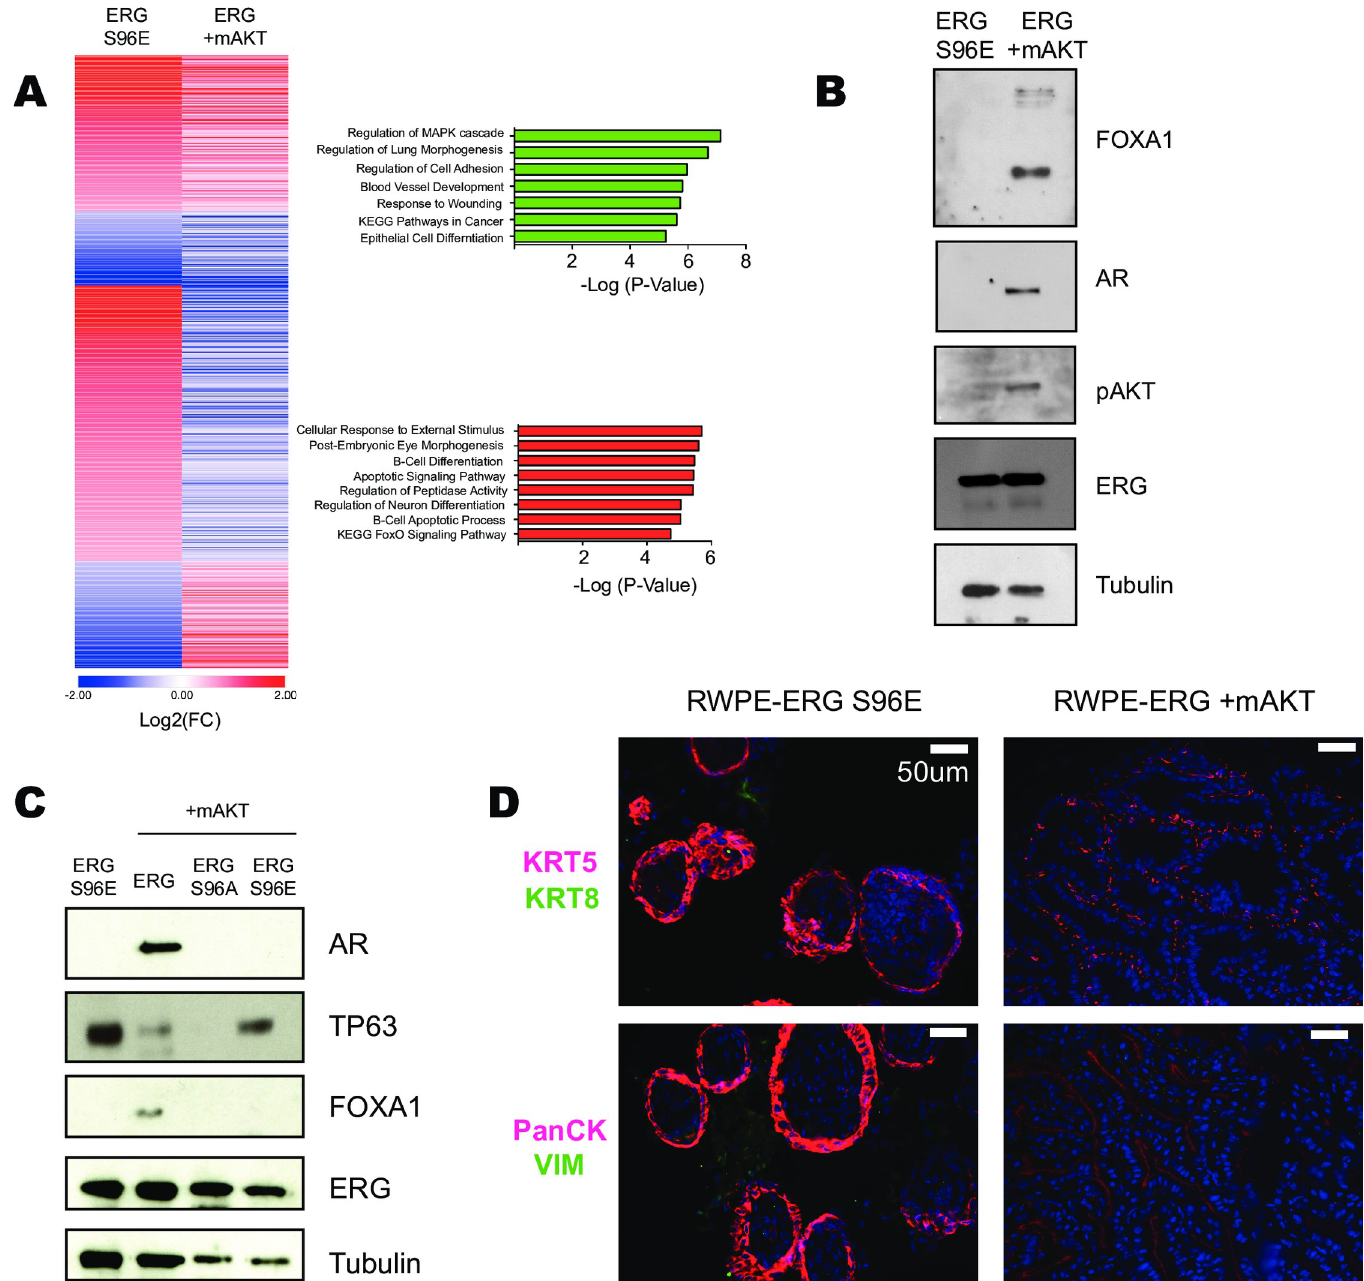
Fig 6. Ras/ERK and PI3K/AKT pathway regulation of ERG result in distinct gene expression programs in prostate cells. (A) Heat map comparison of genes in RWPE1-ERG S96E or RWPE1-ERG/mAKT significantly differentially regulated compared to RWPE1-ERG alone. Gene ontology analysis of co-regulated genes (green) and differentially regulated genes (red). (B) Immunoblot of RWPE1 xenograft tumor lysates comparing those expressing only ERG-S96E and those expressing ERG and mAKT. (C) Immunoblot of RWPE1 xenograft tumor lysates expressing phospho-mutants of ERG. (D) Histology of RWPE1-ERG S96E or RWPE1-ERG/mAKT xenograft tumors. Top images stained for KRT5 (basal) and KRT8 (luminal) markers and bottom images stained for Pan-CK and